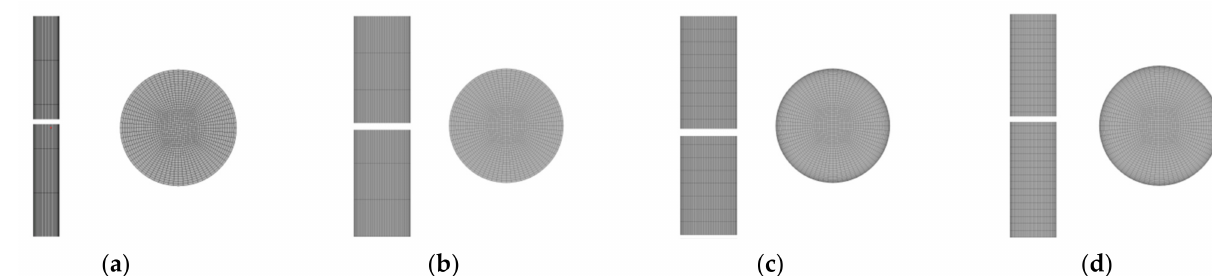
Figure 2. Grids of the all computational domain. ( a ) All-grid-1, ( b ) All-grid-2, ( c ) All-grid-3, ( d ) All-grid-4. Boundary Condition Setting